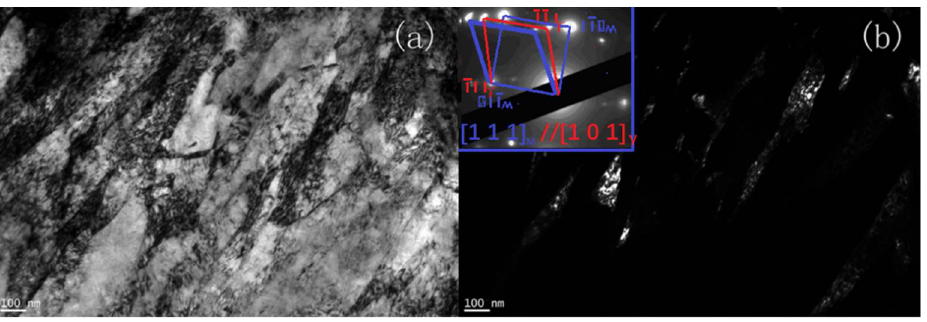
Figure 7. The transmission electron micrograph of the quenching-partitioning-tempering sample: bright field image ( a ) and dark field image ( b ).